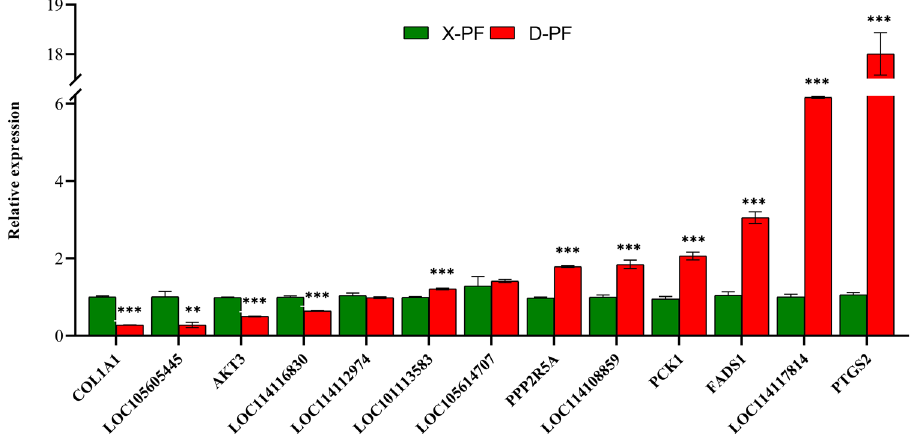
Figure 7. qRT-PCR verification of differentially expressed genes. The differential expression of genes in subcutaneous adipose tissue between Duolang and Small Tail Han sheep was verified qRT-PCR. D-PF represents the subcutaneous adipose tissue of Duolang sheep. X-PF represents the subcutaneous adipose tissue of Small Tail Han sheep. * P value < 0.05; ** P value < 0.01; *** P value <